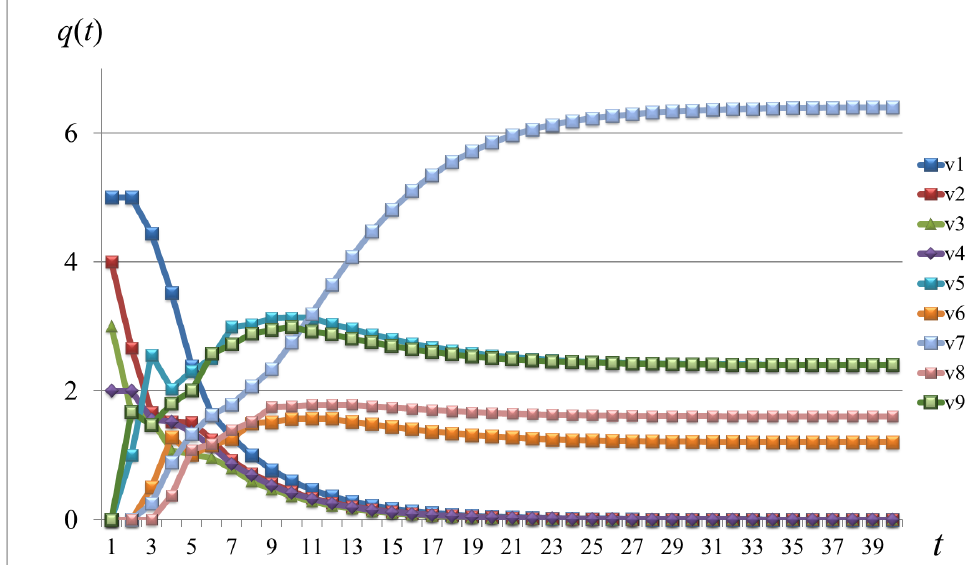
Figure 3. The resource distribution over time for the network represented by matrix (21). W = 14, and the vector of the initial state is Q ( 0 ) = ( 5,4,3,2,0,0,0,0,0 ) . The resource values in vertices ( v 1 – v 4 ) tend to 0; all the resource is concentrated in vertices ( v 5 – v 9